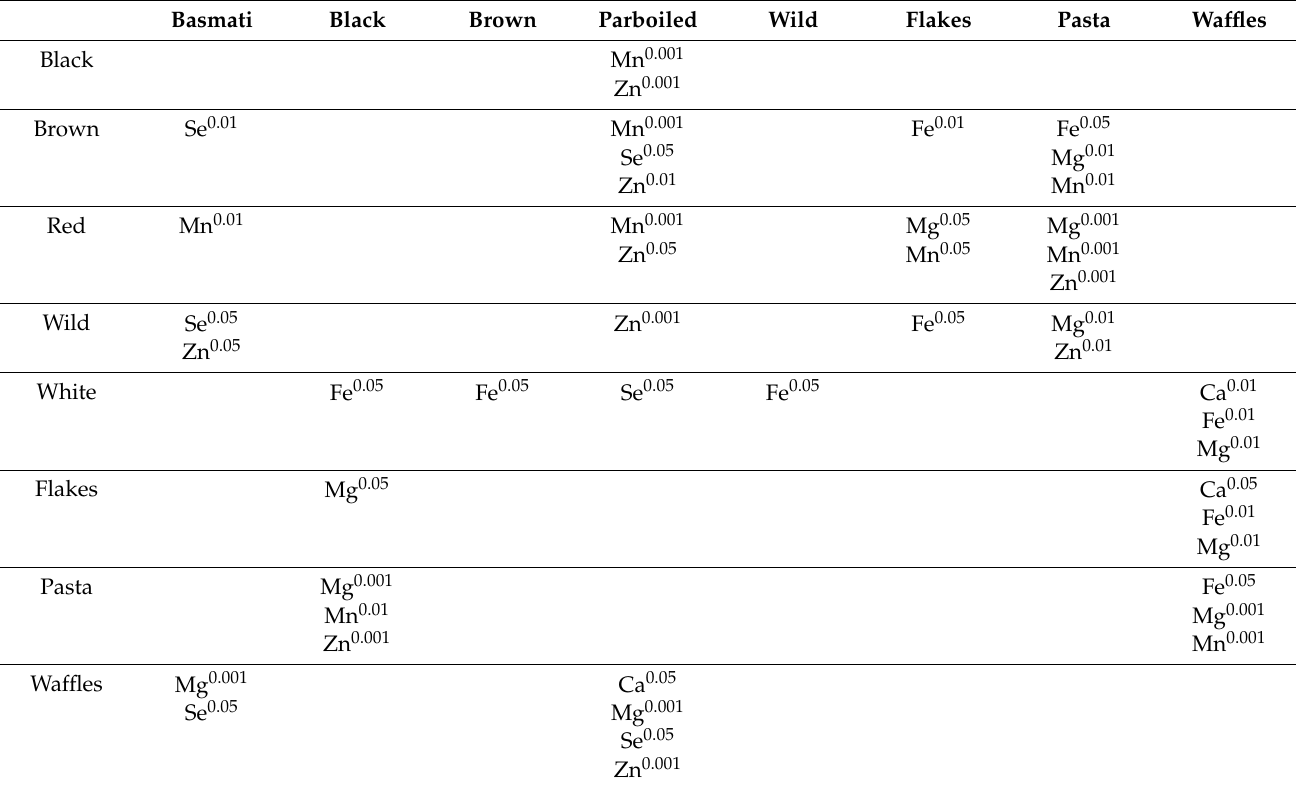
Table 5. The statistically relevant differences in the content of the studied elements considering the type of product. Basmati Black Brown Parboiled Wild Flakes Pasta Waffles Black Mn 0.001 Zn 0.001